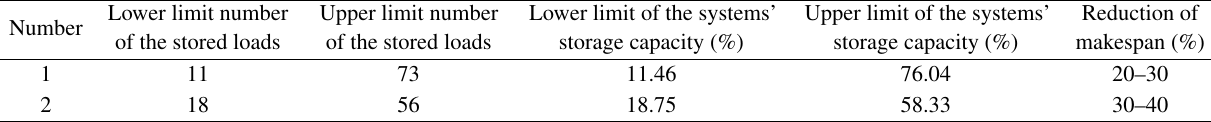
Table 5 Distribution of makespan reduction in the second